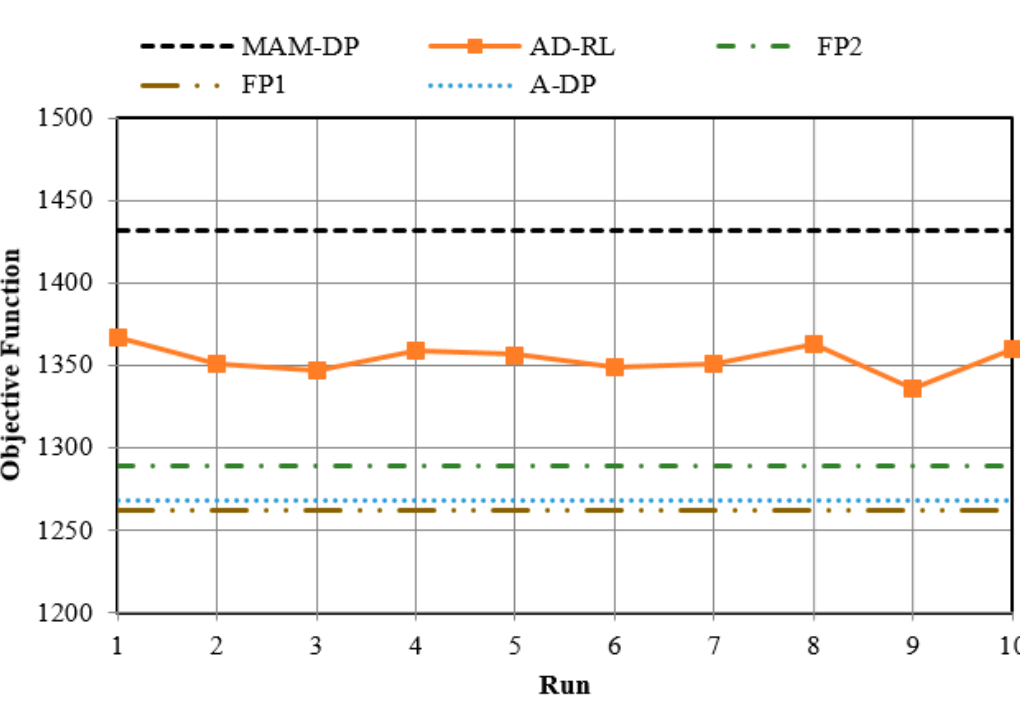
Figure 9. The average expected value of the objective function for 10 different runs.